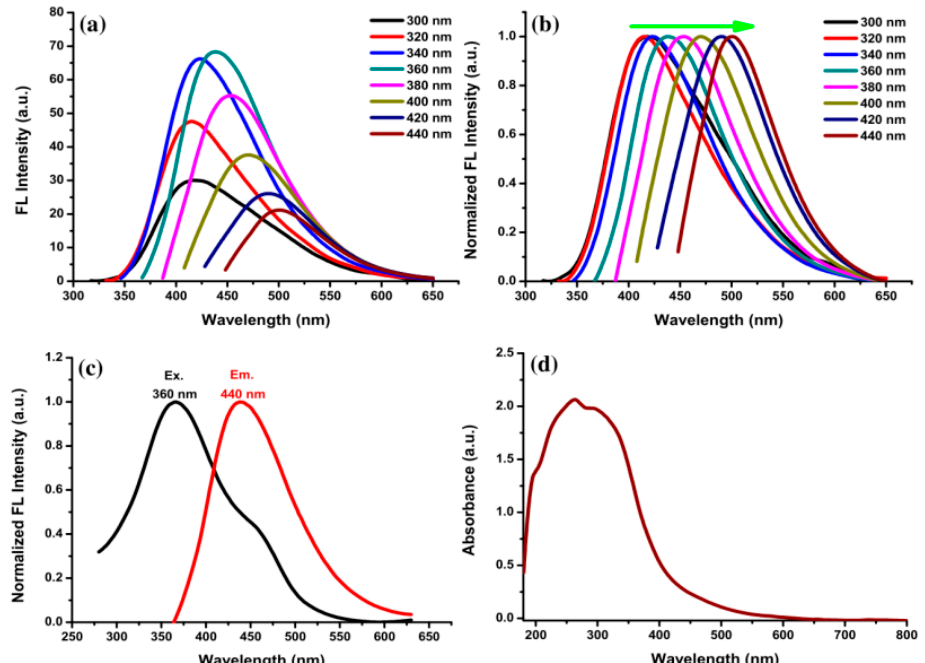
Figure 4. ( a ) FL spectra of VV-CDs solution with excitation wavelengths ranging from 300 to 440 nm; ( b ) normalized spectra of VV-CDs solution with different excitation wavelengths from 300 to 440 nm; ( c ) optimal excitation and emission spectra at 360 and 440 nm, respectively; and ( d ) UV-Vis spectrum of VV-CDs. The VV-CDs solution was diluted by 15-fold of the dilution factor.